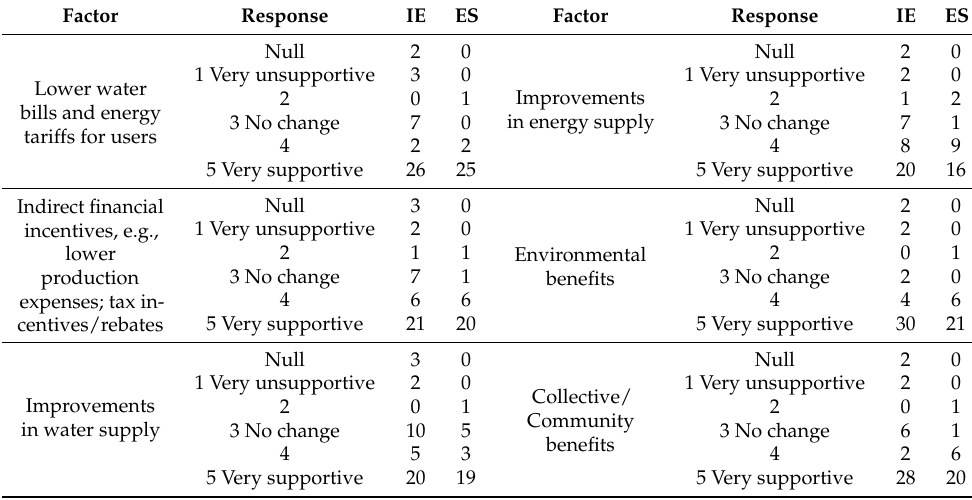
Table 3. Factors influencing the adoption of